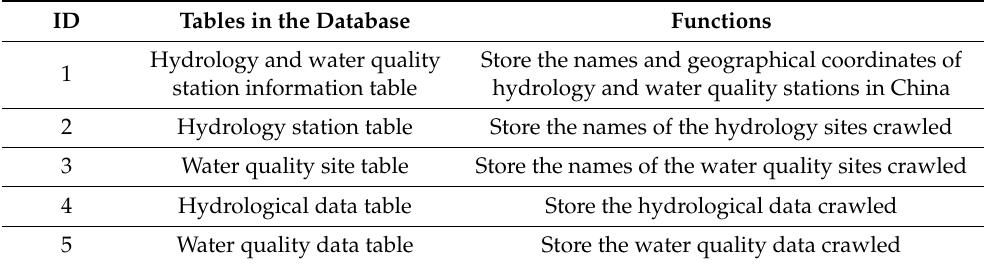
Table 1. The functions of tables used in the database.